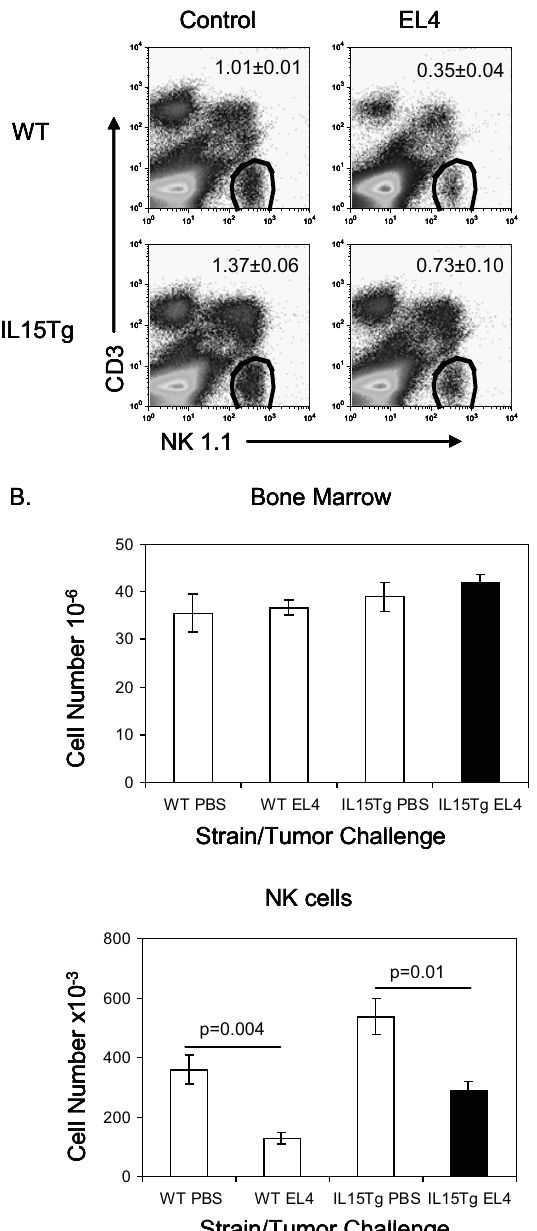
Figure 3. IL15 does not prevent loss of NK cell number. IL15Tg and littermate controls were injected with PBS or EL4. After 3 weeks, bone marrow was evaluated for NK cell number. A. FACs profile of NK1.1 + CD3 2 cells obtained from WT or IL15Tg mice with or without tumor. B. Bone marrow cellularity and absolute number of NK cells. The absolute number of NK cells was calculated by multiplying the percentage of NK1.1 + CD3 2 cells by the number of bone marrow cells. Data shown were means and SEM, involving 4 mice per